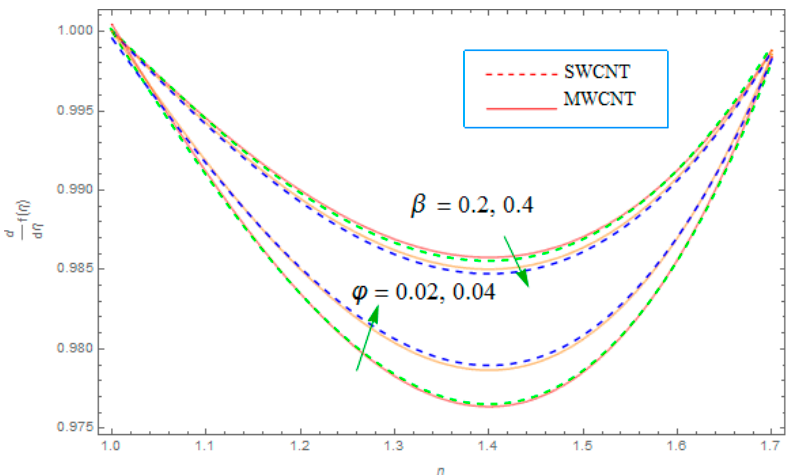
Figure 3. df ( η ) distribution for varying Gr . d η distribution for varying Gr . η